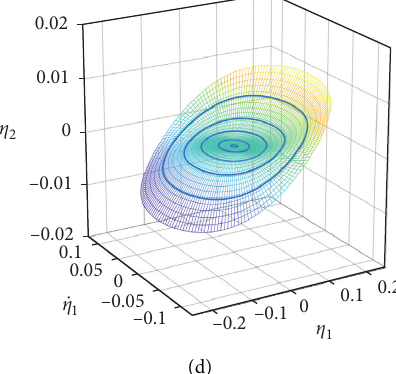
Figure 9: The forced responses of a type III two-stage isolator in primary resonance, for 􏽢 k motions on the approximate NNM invariant manifold for the underlying conservative system. (a) Displacement amplitude-frequency responses for the payload and the ones for the lower stage of the isolator under harmonic force excitations with different amplitude F : pink solid line represents F � 0 . 0001; blue dashed line represents F � 0 . 0005; green dotted line represents F � 0 . 0010; red dashed-dotted line represents F � 0 . 0015; black solid line represents F � 0 . 0020. The other system parameters are the same as in Figure 2. (b) Five repre- sentative forced responses in primary resonance of the system are shown in different line styles, which correspond, respectively, to the solid points on the curves in (a) with the same color and line style. Five corresponding free periodic trajectories of the underlying conservative system are shown in solid lines, and they are also presented in (c) and (d) for different phase space. (c-d) The approximation of the NNM invariant manifold for the displacement constraint 􏽢 x procedure are N a � 21, with 20 equally sized elements in the domain a | a ∈ [ 0 , 0 . 20 ]{ } , and N